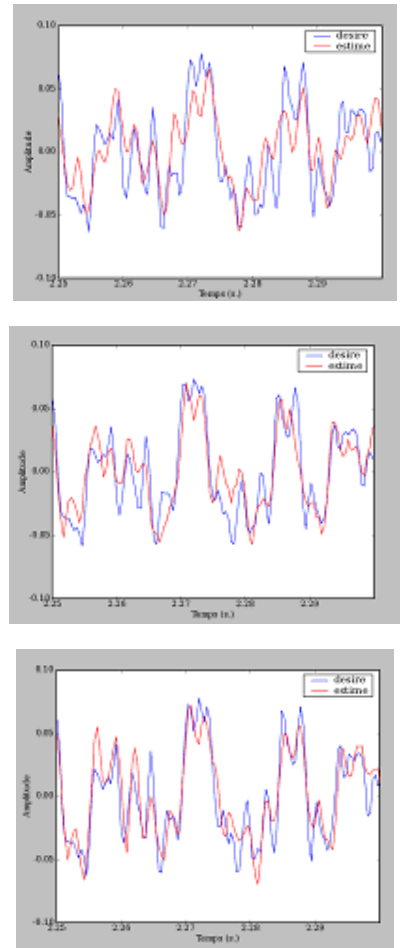
Figure 14: example of restitution using MS correlation only (up scheme), tilt only (middle scheme), and MS and tilt correlation (bottom scheme) – in blue the signal to assess; in red the signal